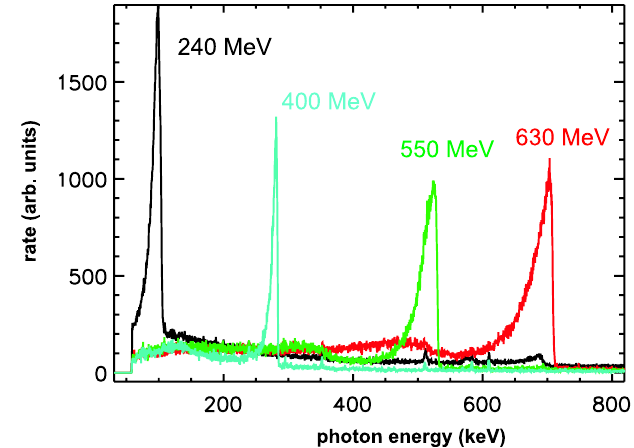
FIG. 4. (Color) Typical spectra of Compton-backscattered pho- tons for high electron beam energies.